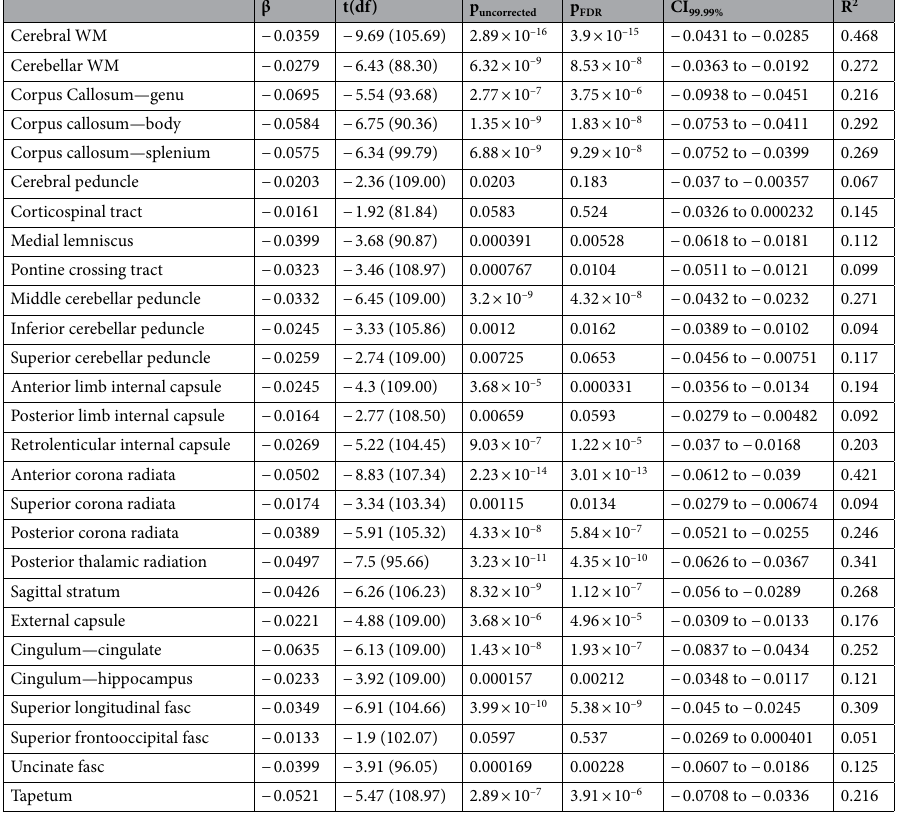
Table 3. Group differences in fractional